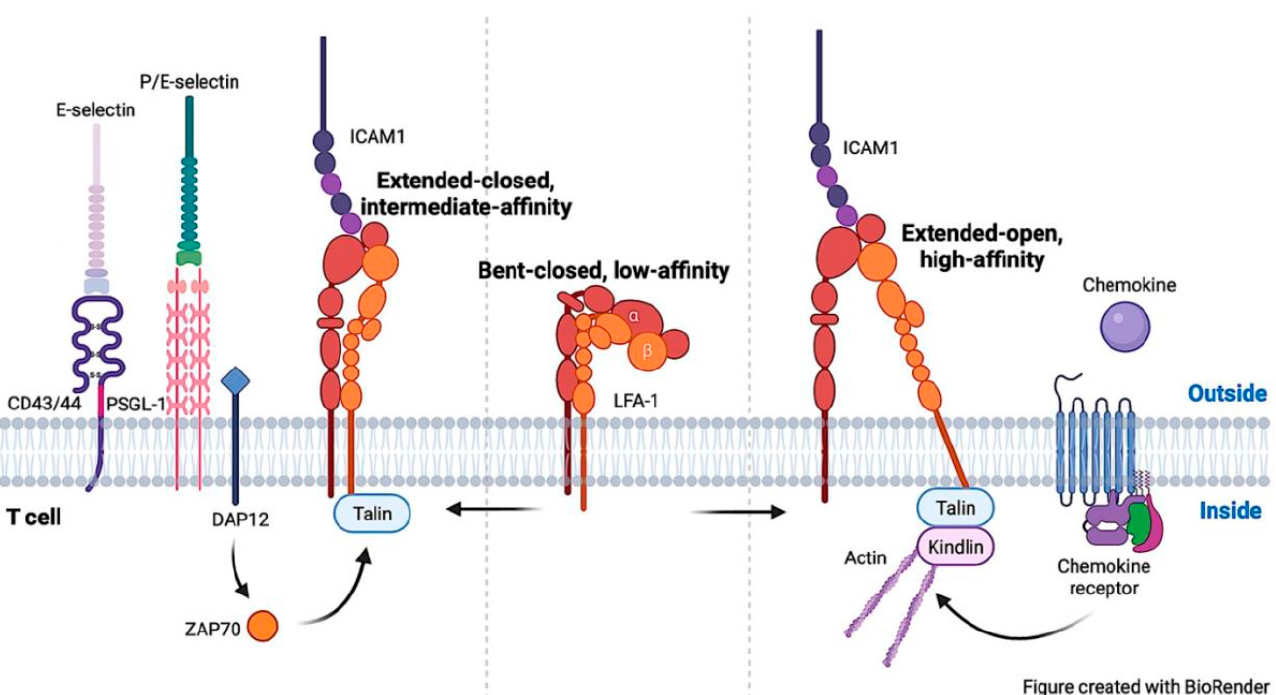
Figure 2. LFA-1 activation during T-cell migration, conformations and a ffi nities in T cells. Signaling from engagement of selectins and chemokines during T-cell migration activates LFA-1 to the intermediate- and high-a ffi nity states, respectively. Talin1 binding to di ff erent sites on the integrin β 2 tail of the intermediate- and high-a ffi nity LFA-1. LFA-1 in the high-a ffi nity state associates with the actin cytoskeleton, but it is not clear whether the intermediate-a ffi nity LFA-1 is linked to the cytoskeleton in response to selectin engagement. In addition, kindlin3 is required for LFA-1 activation by chemokines but not selectins. Interestingly, DAP12 is expressed in e ff ector T cells and plays an essential role in selectin-mediated LFA-1 activation.